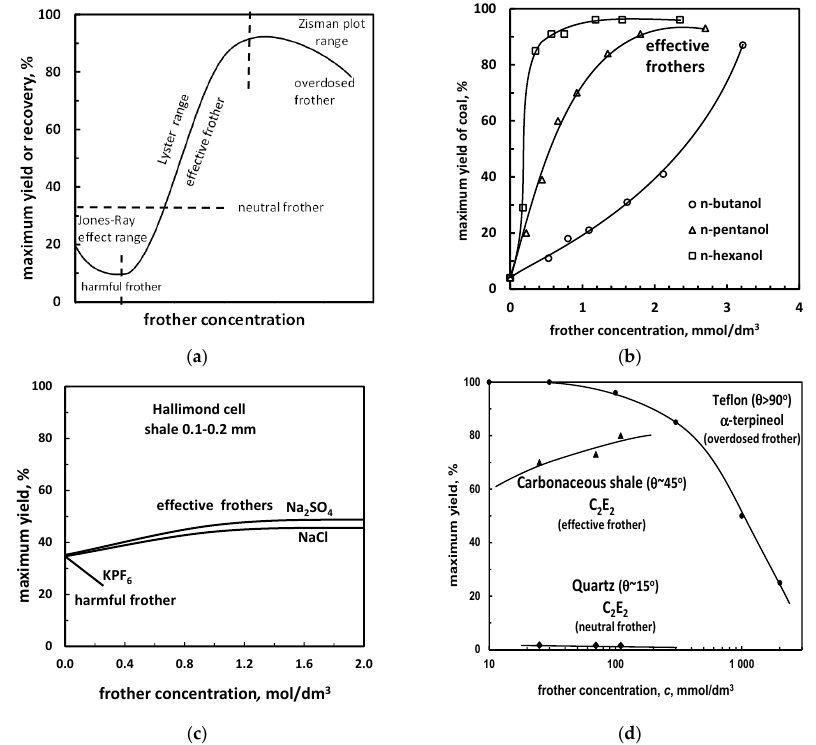
Figure 11. Classification of frothers into effective, neutral, harmful and overdosed ( a ). Examples: ( b ) medium hydrophobicity material (coal)/different surfactants (yield and effectiveness increase with frother concentration) (data after [50], flotation time 2.5 min); ( c ) medium hydrophobicity material (carbonaceous shale)/different inorganic salts (based on data of [55]); ( d ) differently hydrophobic materials/surfactant (based on data of [56,57]).